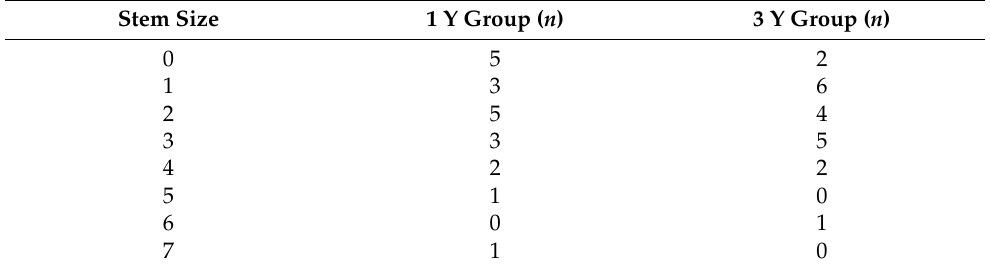
Table 2. Stem size distribution.